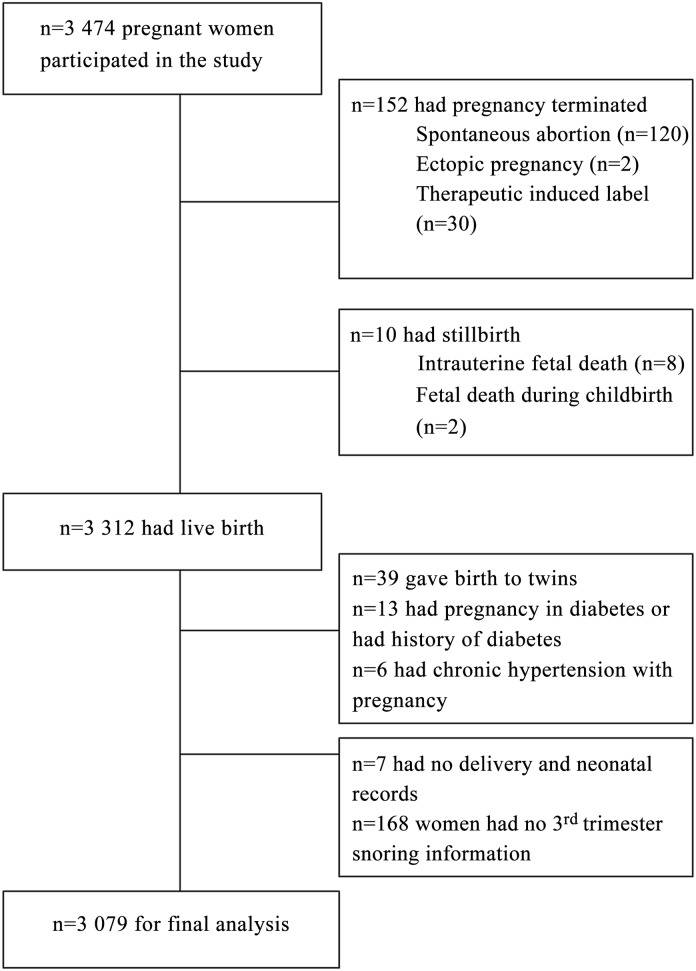
Recruitment flowchart.